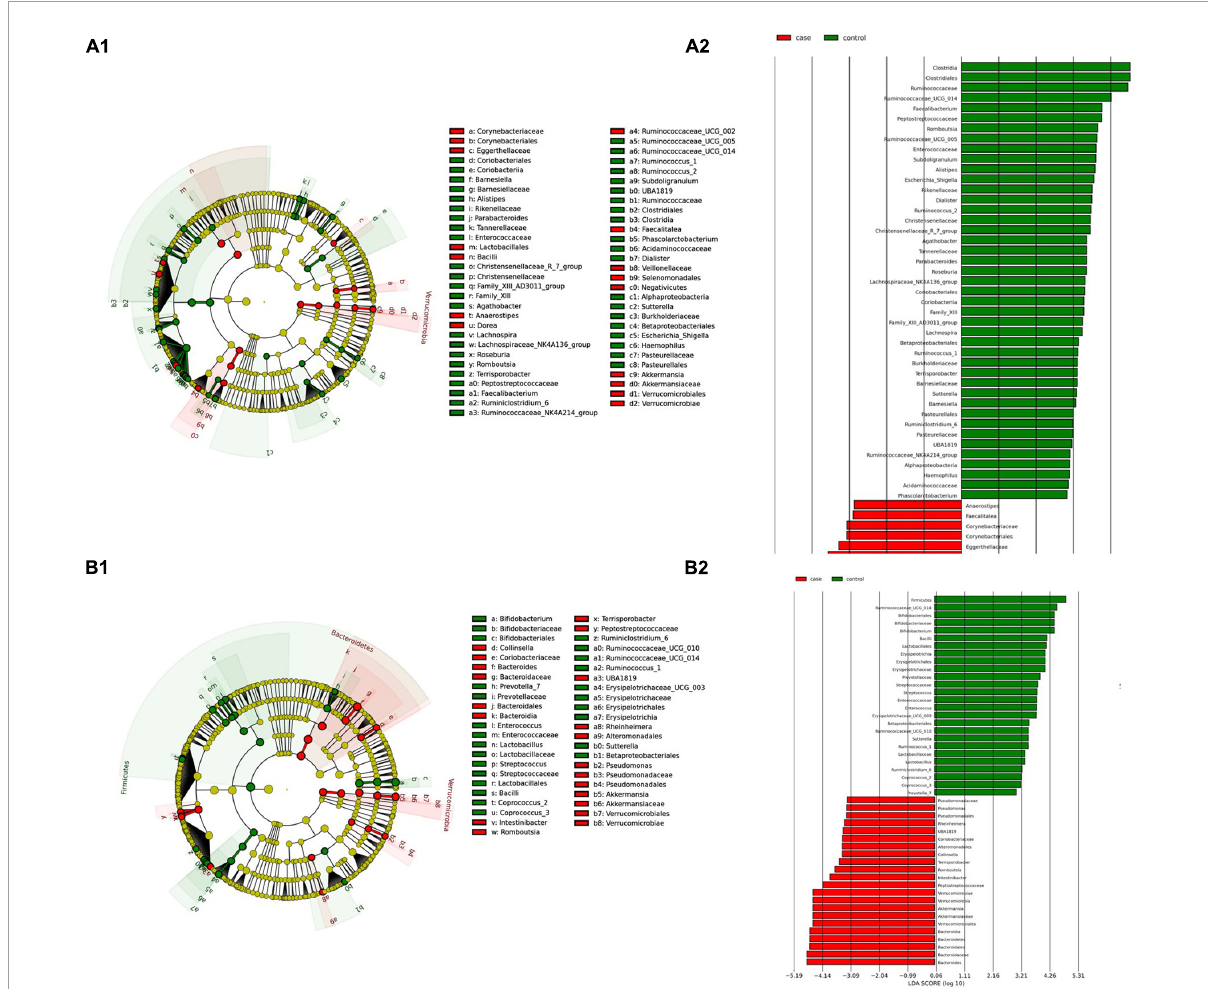
FIGURE5 Linear discriminant analysis (LDA) integrated with effect size (LEfSe). Cladogram representing the differentially abundant taxonomic groups in the microbiota from the stool of Patients with CeD following an unrestricted diet (A.1) or a GFD (B.1) . Graph bar representing the microbial biomarkers found in the microbiota from the stool of Patients with CeD following an unrestricted diet (A.2) or Patients with CeD following a GFD (B.2) (LDA score > 3, p < 0.001). Control: Control group, represented in green. Case: Patients with CeD, represented in red.